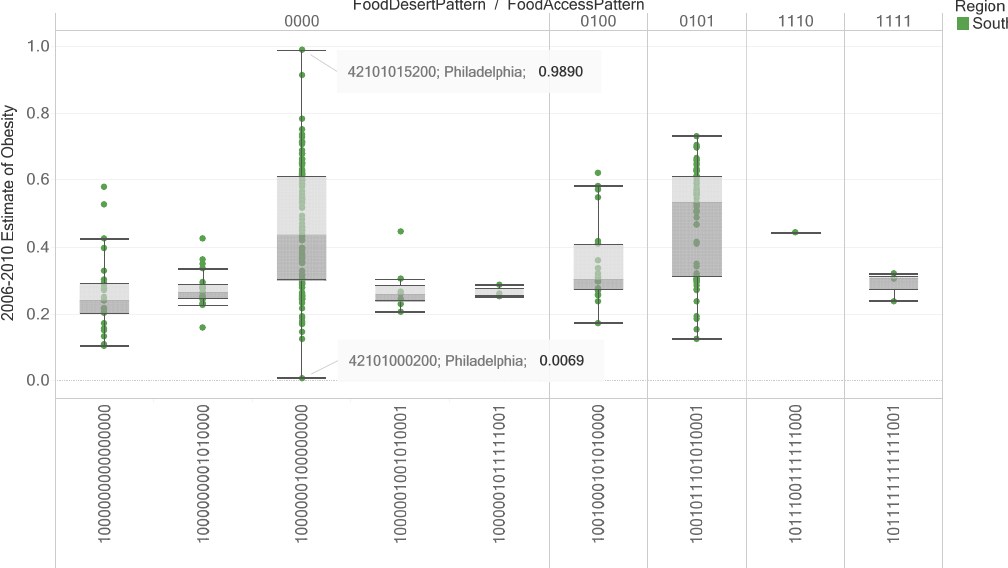
Figure 11. Regional comparison of estimates of obesity rates (2006–2010) for census tracts with the same food access pattern in Philadelphia County, Southeast Pennsylvania. We designed the box plot to support decisions on differences in obesity rates in a county (attention and motivation functions of knowledge visualization). The design of the view allows one or more counties to be selected (elaboration function of the knowledge visualization).